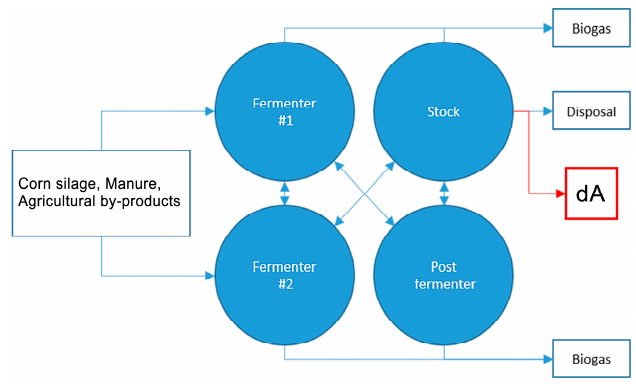
Figure 6. Schematic view of treatment plant producing digestate dA.